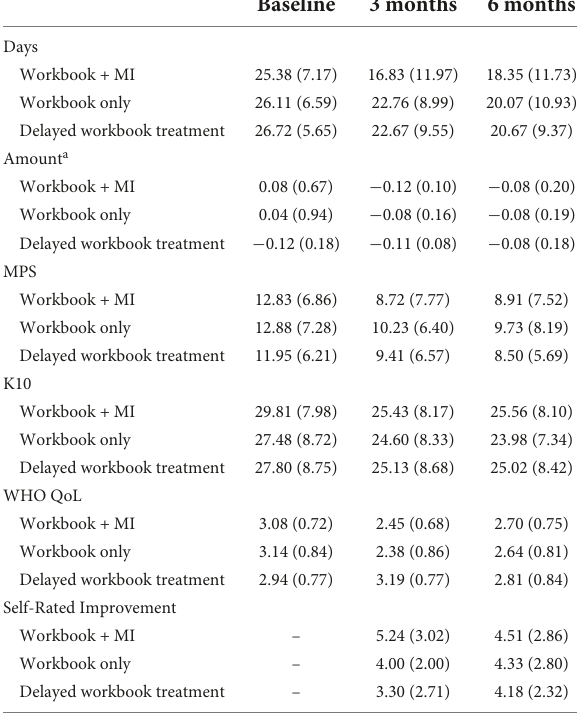
TABLE 5 Means (and SDs) for primary and secondary outcomes at baseline and follow-up